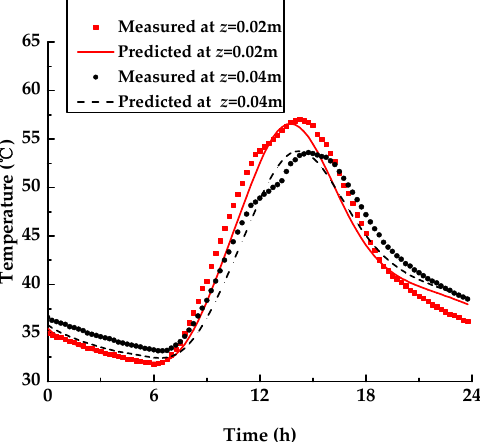
Figure 5. Measured and predicted temperature at z = 0.02 m and z = 0.04 m on 24 August.